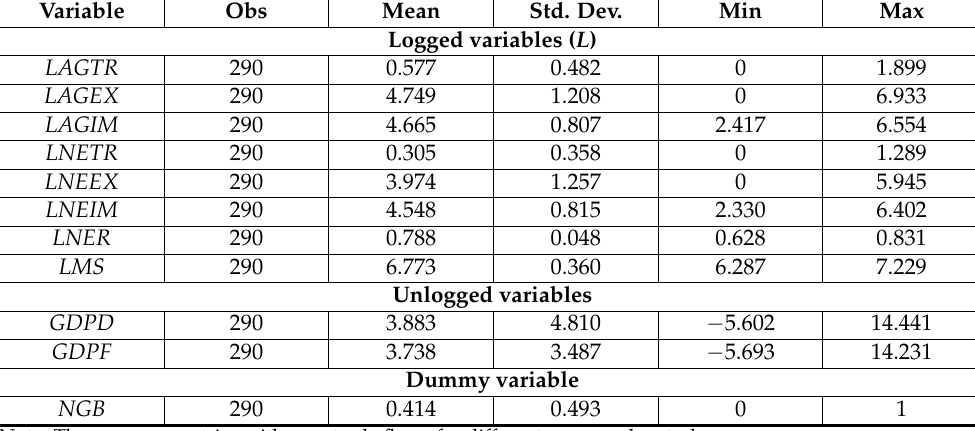
Table 1. Summary statistics of variables under